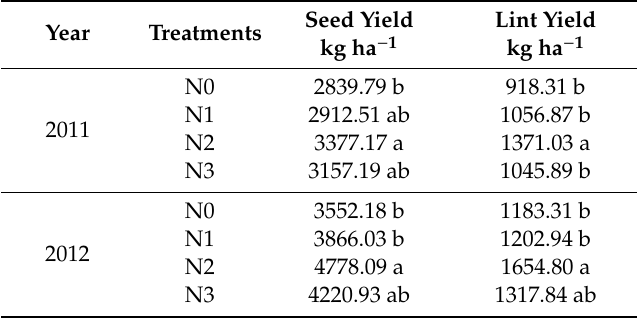
Table 3. Seed yield and lint yield in cotton fertilization rate studies conducted in the Yellow River Basin of China in 2011 and